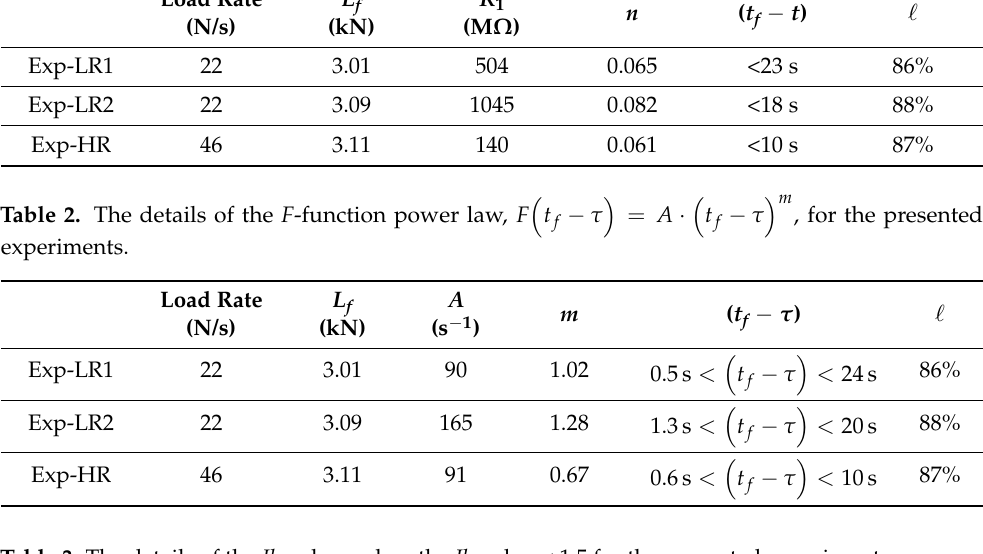
Table 1. The details of the resistance ( R ) power law, R experiments.